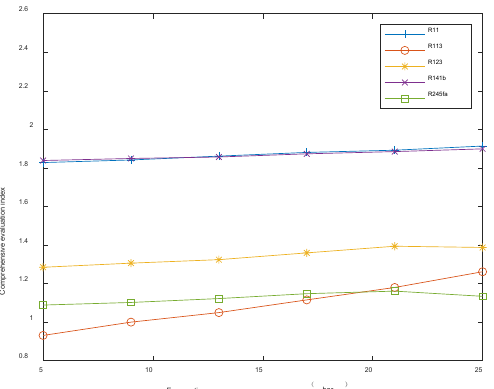
Figure 11. Effect of the evaporation pressure of different organic working fluids on the comprehensive evaluation index.